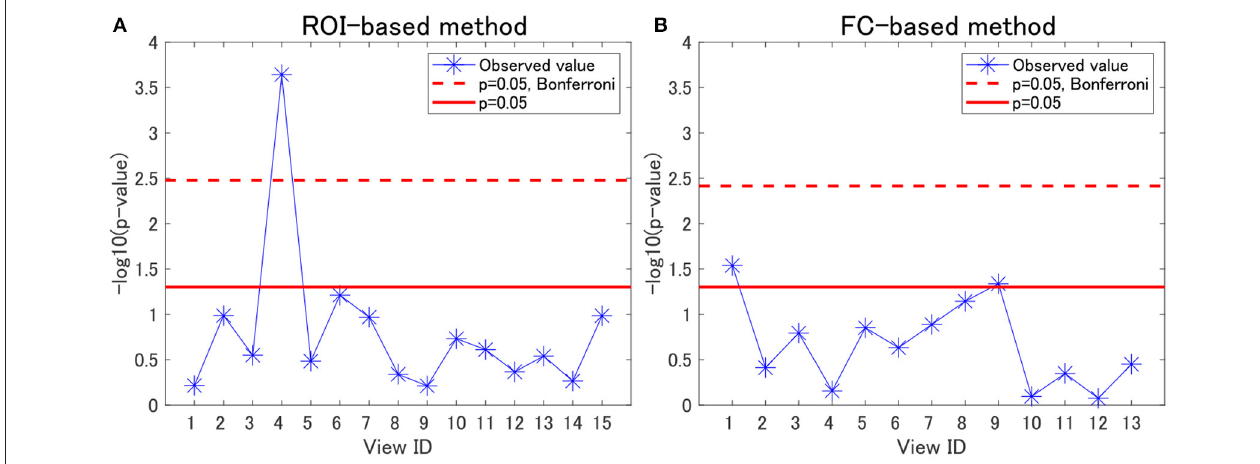
FIGURE 2 | Associations between cluster labels and psychiatric disorders. (A) Results of the ROI-based multiple clustering method. (B) Results of the FC-based multiple clustering method. The horizontal axis denotes the view ID, whereas the vertical axis denotes the negative logarithm of the p -value yielded by the χ 2 test to evaluate the association between the corresponding cluster labels in the view and psychiatric labels. The red line denotes the significance level at 0.05, whereas the dotted line denotes the significance level at 0.05, with Bonferroni correction.